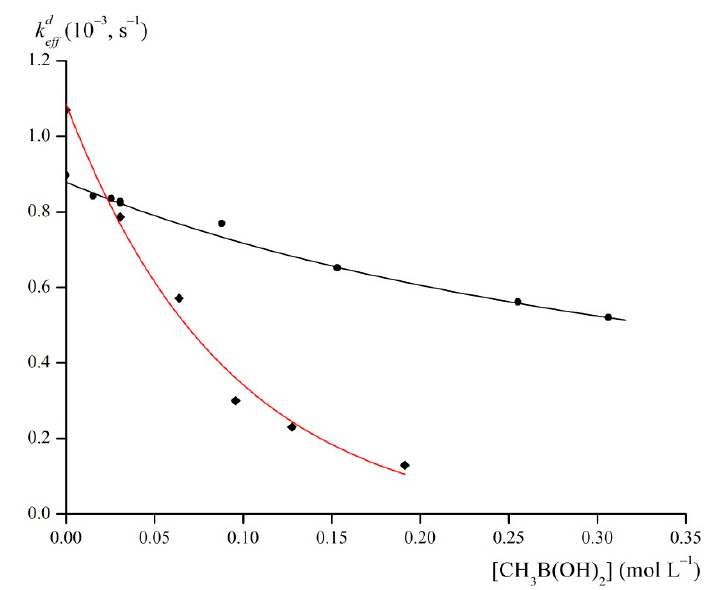
Figure 14. Plots of k d of the acidic decomposition of clathrochelates FeOx 3 (BCH 3 ) 2 (this work, ef f 5 , shown in red) and FeNx 3 (BCH 3 ) 2 ( 4 , shown in black) versus the concentration of methylboronic acid at the activities of H + ions equal to 7.39 × 10 − 2 and 3.62 × 10 − 2 mol L − 1 , respectively. Adapted from ref. [6].